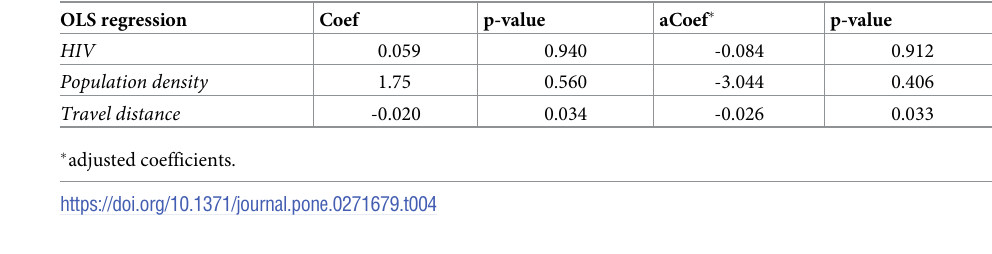
Table 4. Results of OLS regression with spatial weights matrix for community level factors.